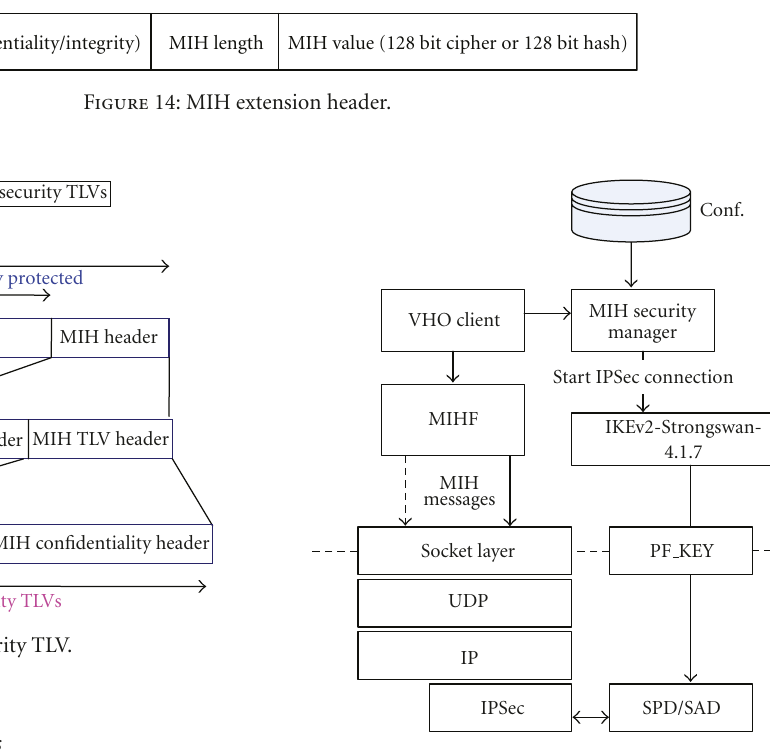
Figure 16: System software architecture in MMT and AR with MIHF and IPSec